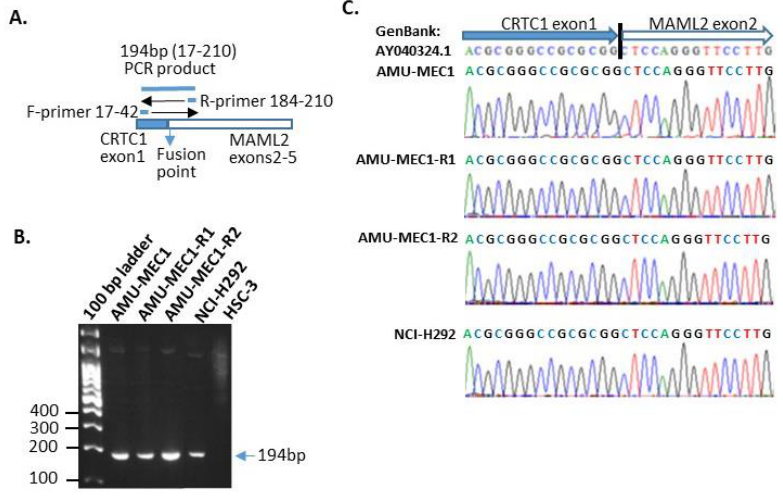
Figure 3. Detection and sequencing of RT-PCR amplified CRTC1-MAML2 chimeric gene. ( A ) The scheme of CRTC1-MAML2 chimeric gene amplification. The primer binding site was designed to span the mRNA fusion point and generate a 194 bp amplicon. ( B ) Chimeric gene detection in the RT-PCR products from each cell. ( C ) Sequence analysis of RT-PCR products from each cell.